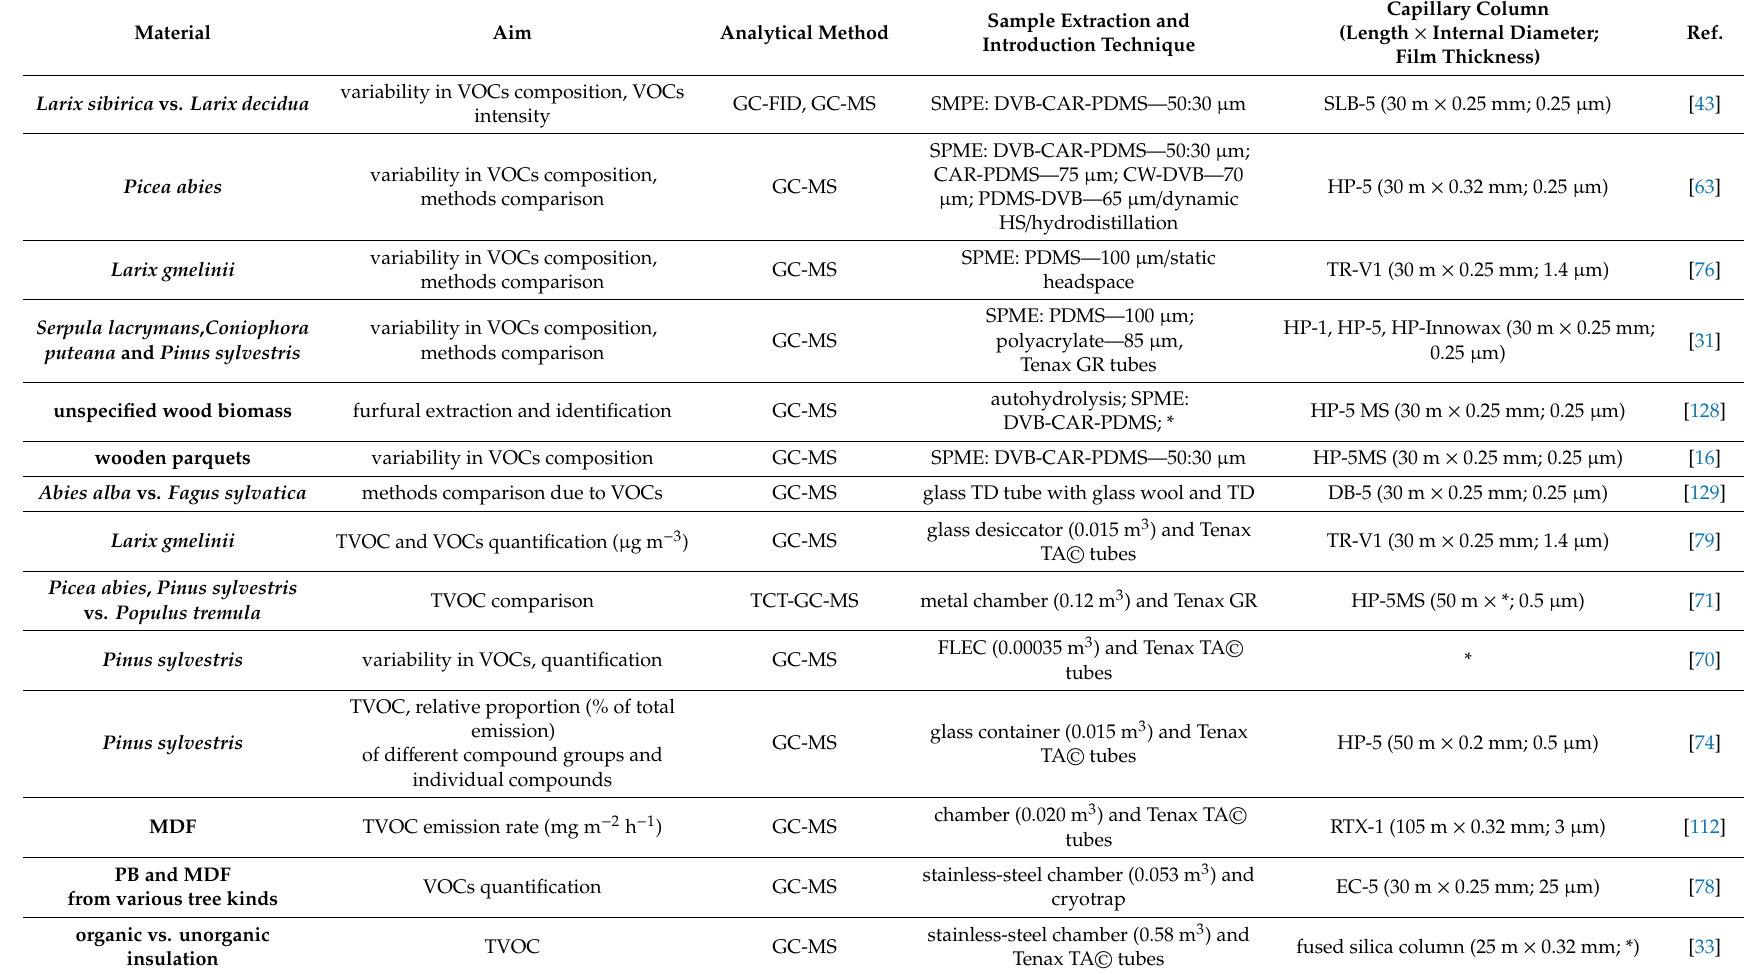
Table 2. Methods applied to assess VOCs from wood and wood-based